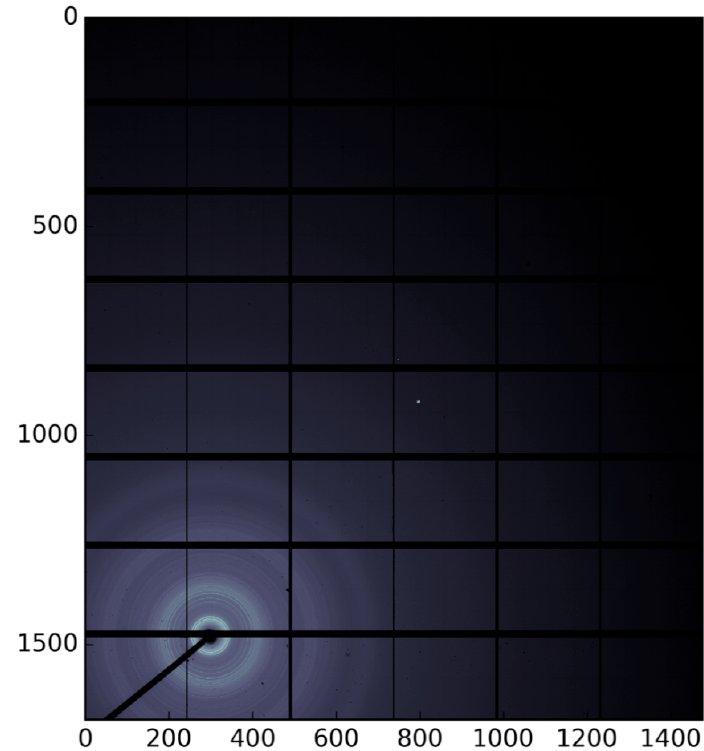
Figure A2. Raw two-dimensional images of PEDOT.